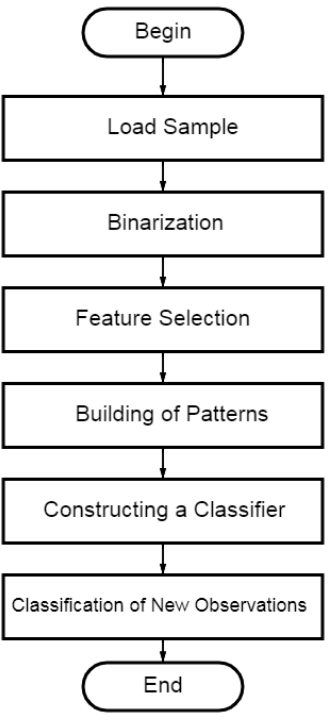
Figure 1. The block diagram of the program